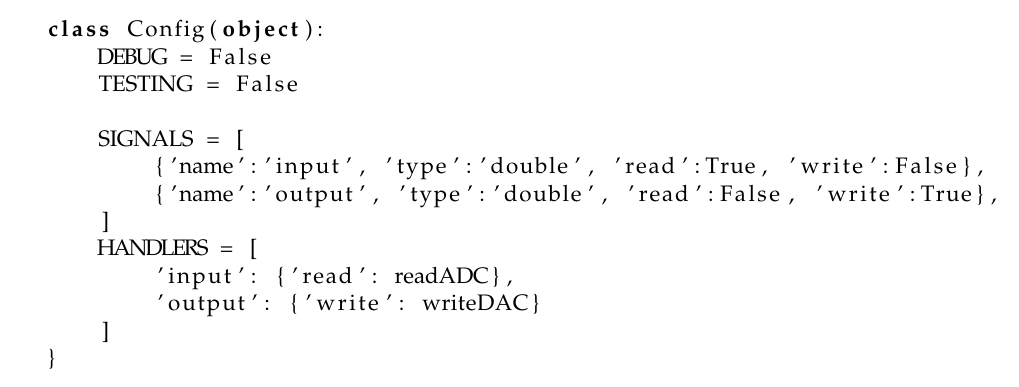
Figure 10. Configuration file of the remote laboratory